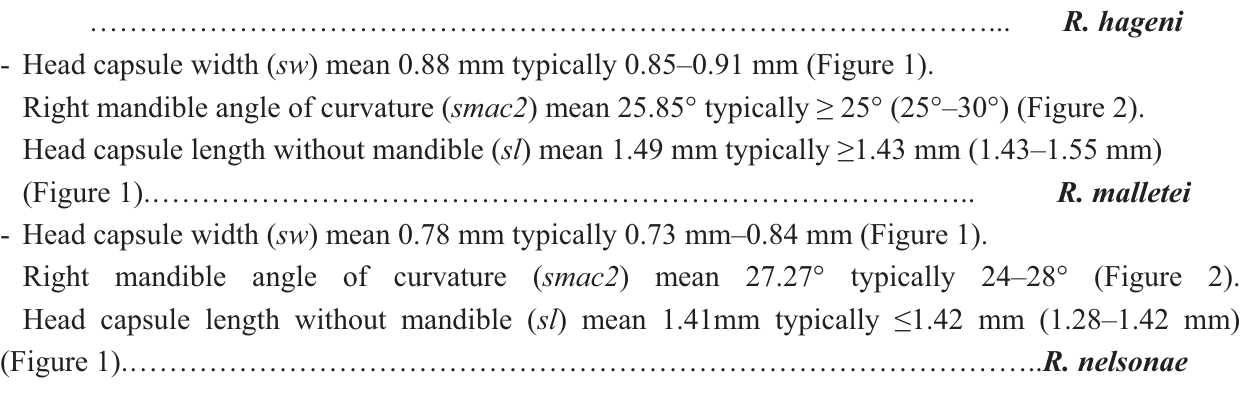
of curvature mean 27.27° typically